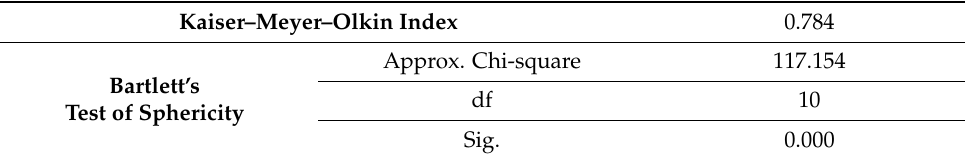
Table 3. Kaiser–Meyer–Olkin coefficient and Bartlett’s test of sphericity.